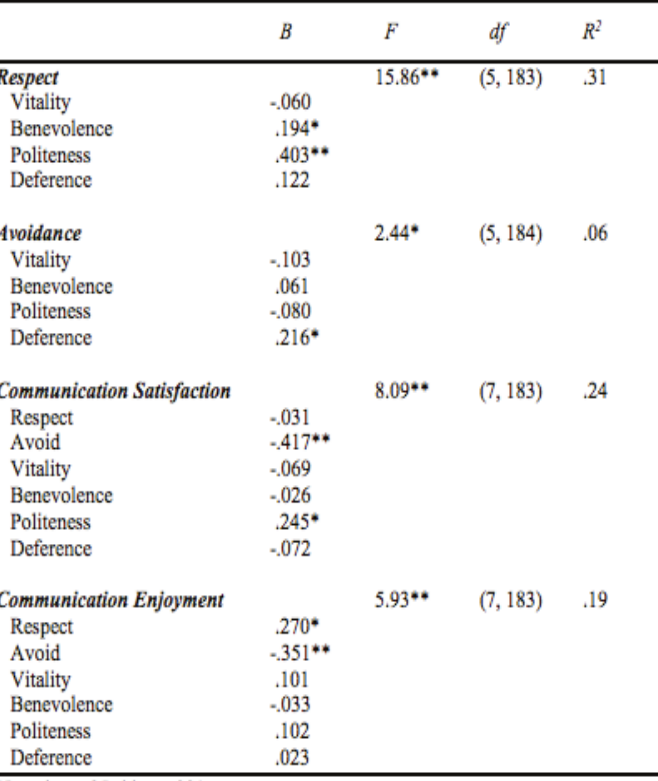
Regression Results for USA Data (Middle-Aged Adults) Regression Results for Mongolia Data (Middle-Aged